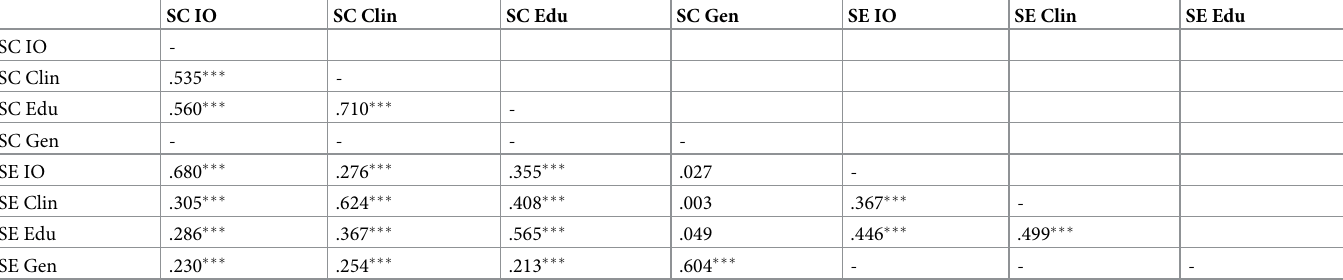
Table 5. Correlations between ability self-concept and self-efficacy factors within the combined incomplete bifactor model with eight first-order factors and two g factors (Model D2). SC IO